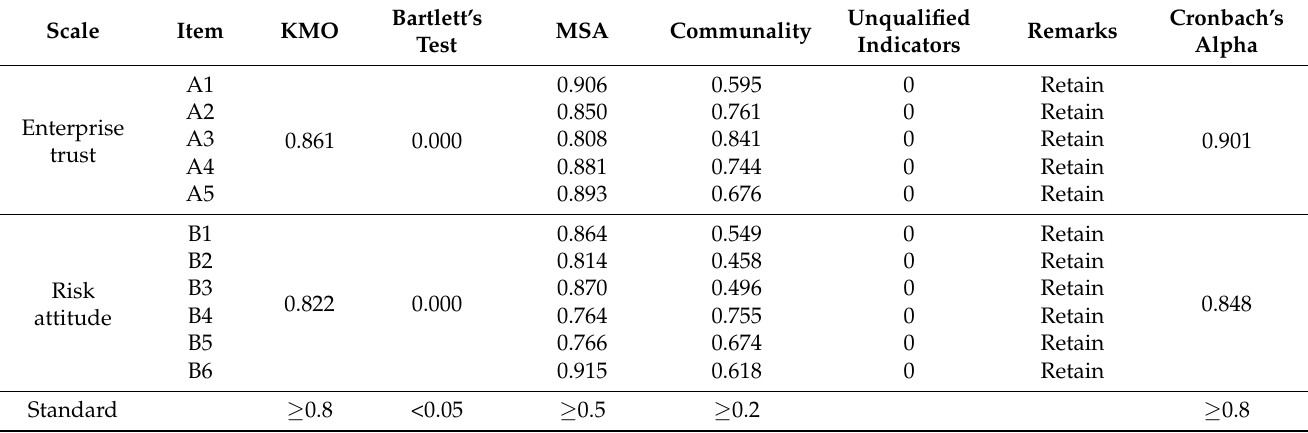
Table 2. Reliability and validity analysis of enterprise trust and risk attitude.